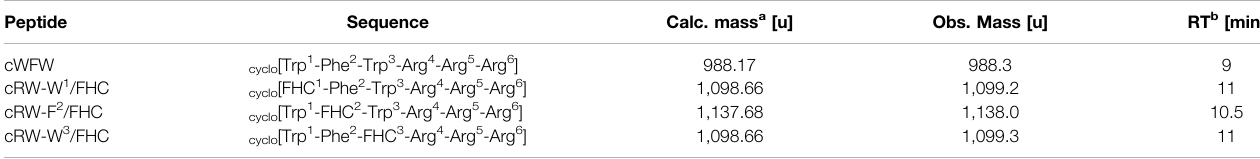
TABLE 1 | Nomenclature, sequences, and characterization data of the peptides studied in this work. Peptide